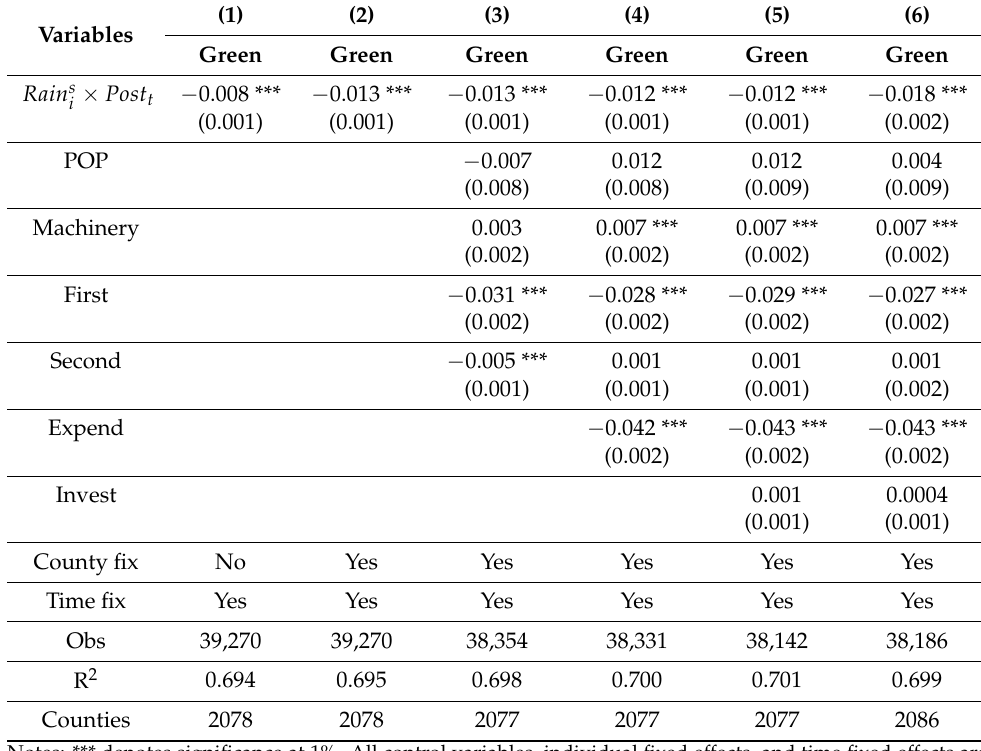
Table 4. Baseline estimations: Impact of the snow disaster on the GAD